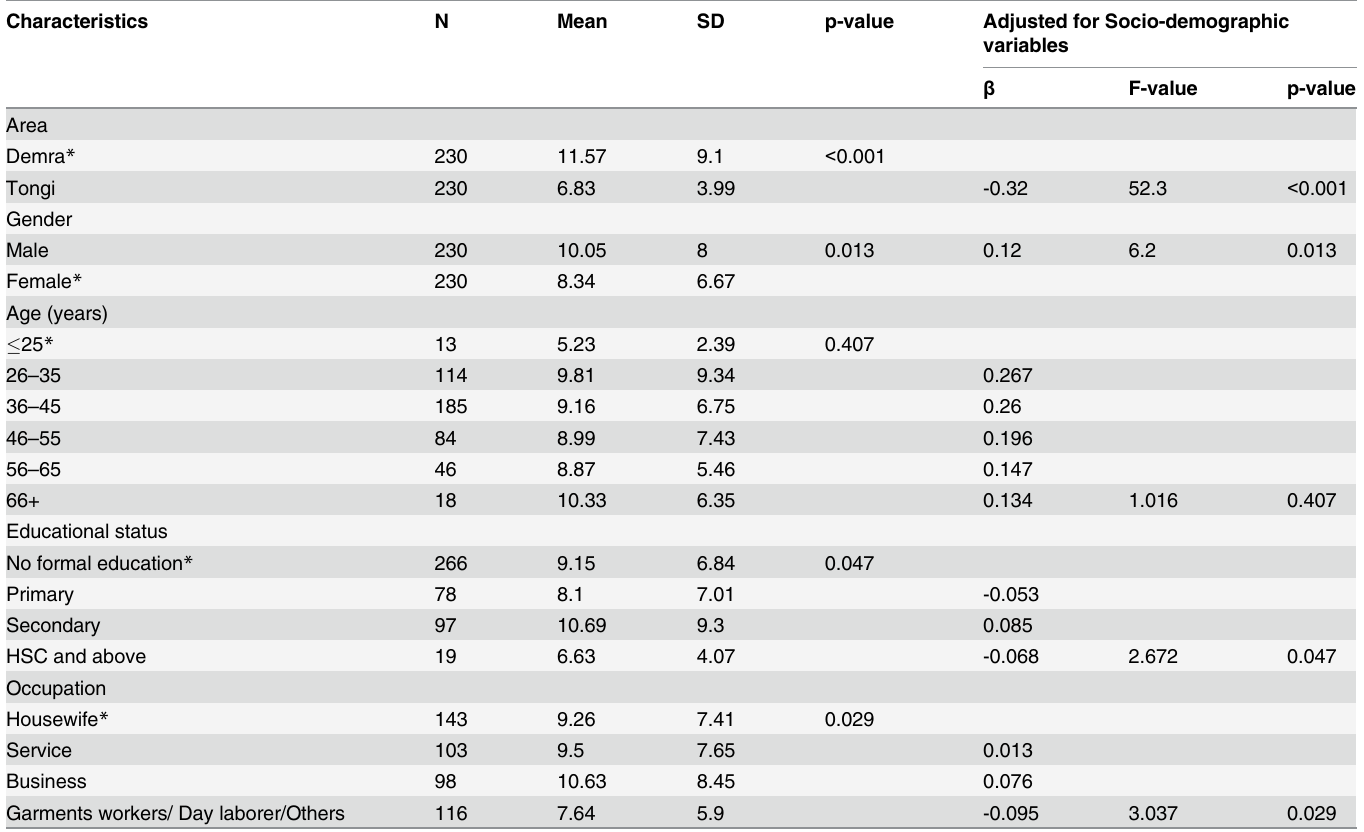
Table 3. Frequency of smokeless tobacco daily use and social-demographic features.